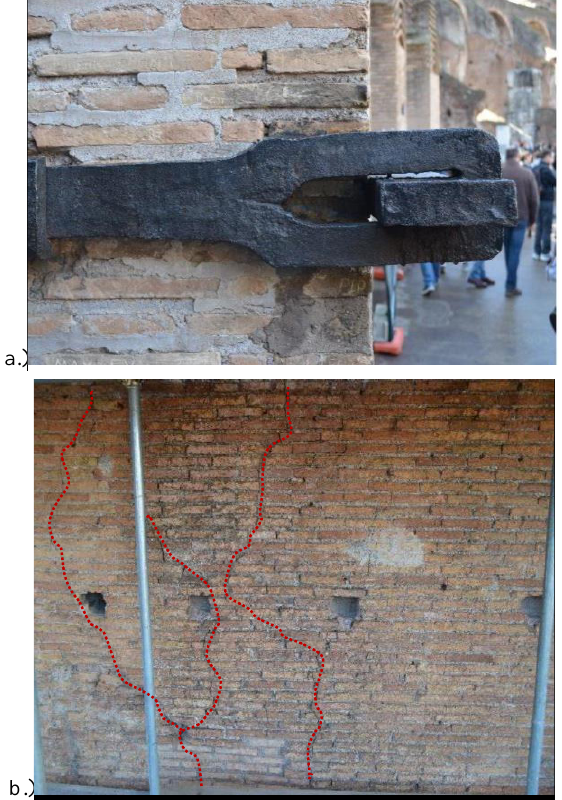
Figure 16. a.) Metal ties on the second floor, that connect column 1 with the masonry orthogonal wall; b.) Crack pattern, highlighted in red, of the same masonry wall at the first